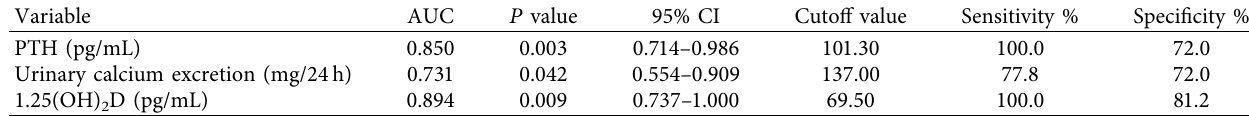
Table 3: Predictors of occult renal calcifications in NPHPT